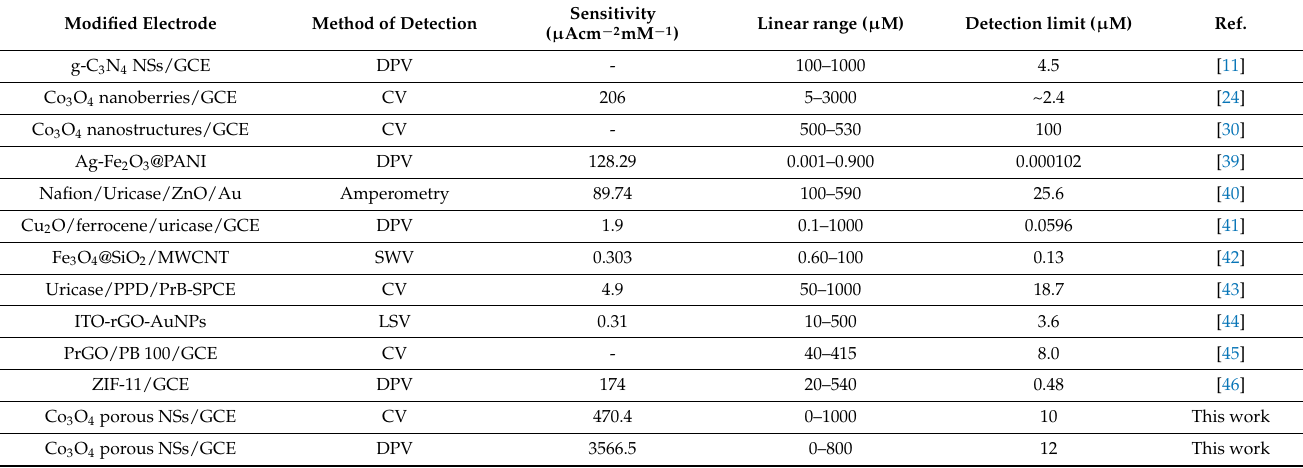
Table 1. Sensing performance comparison with previous reports based on electrochemical studies.